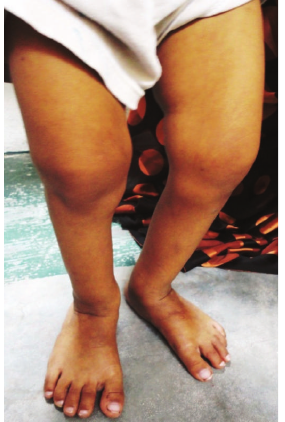
Figure 13: Showing bowed legs and enlargement of ankles.